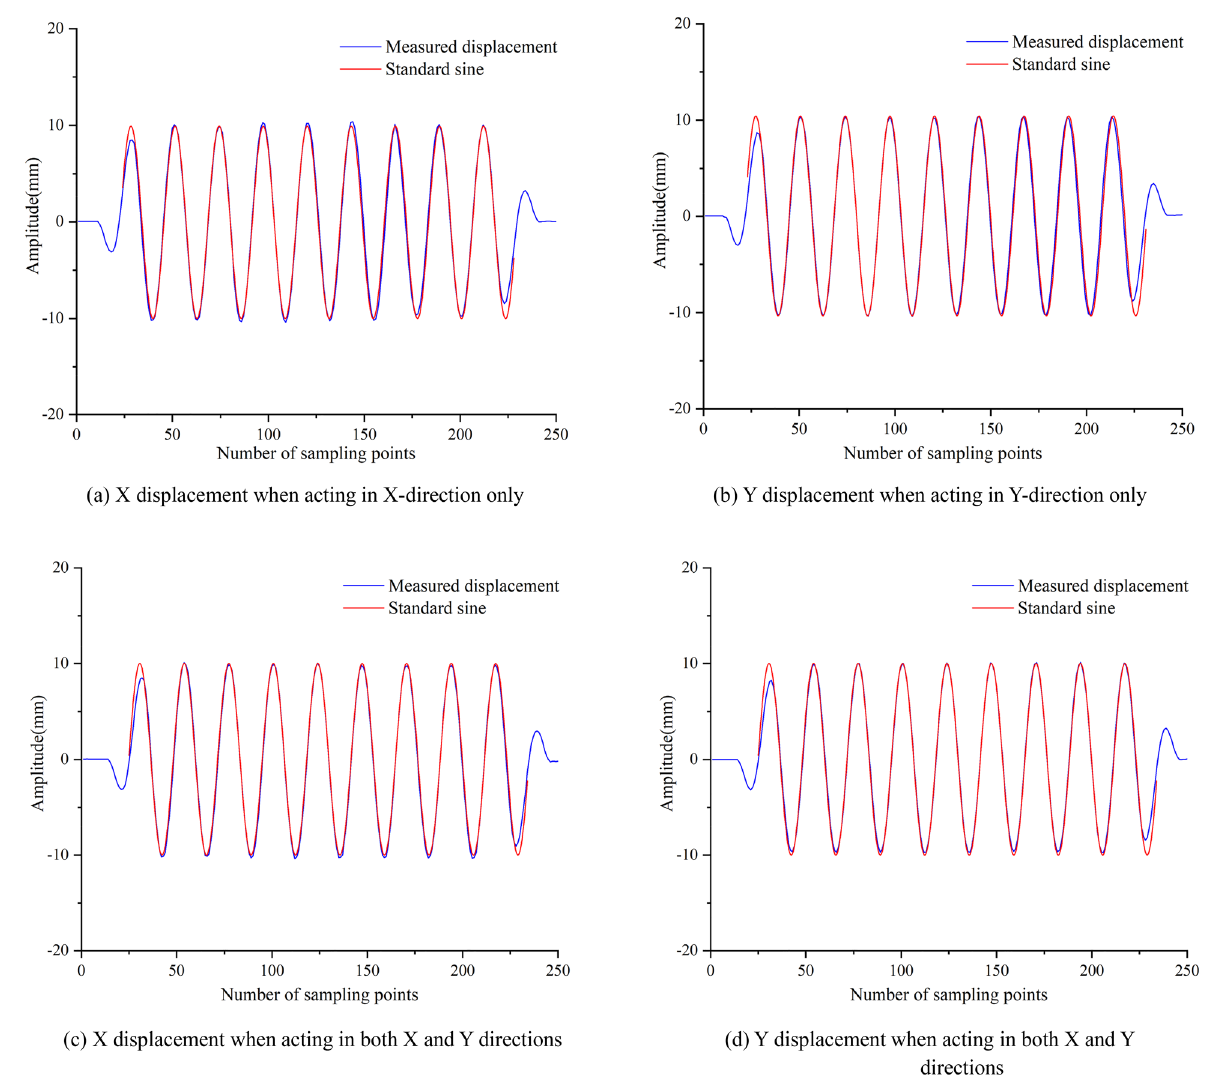
Figure 23. Comparison of measured displacement and standard displacement with measured frequency of 0.9 Hz and displacement of 10 mm (( a , b , c , d ) were generated by Origin 2016 × 64 (https:// www. origi nlab. com/ 2016)).